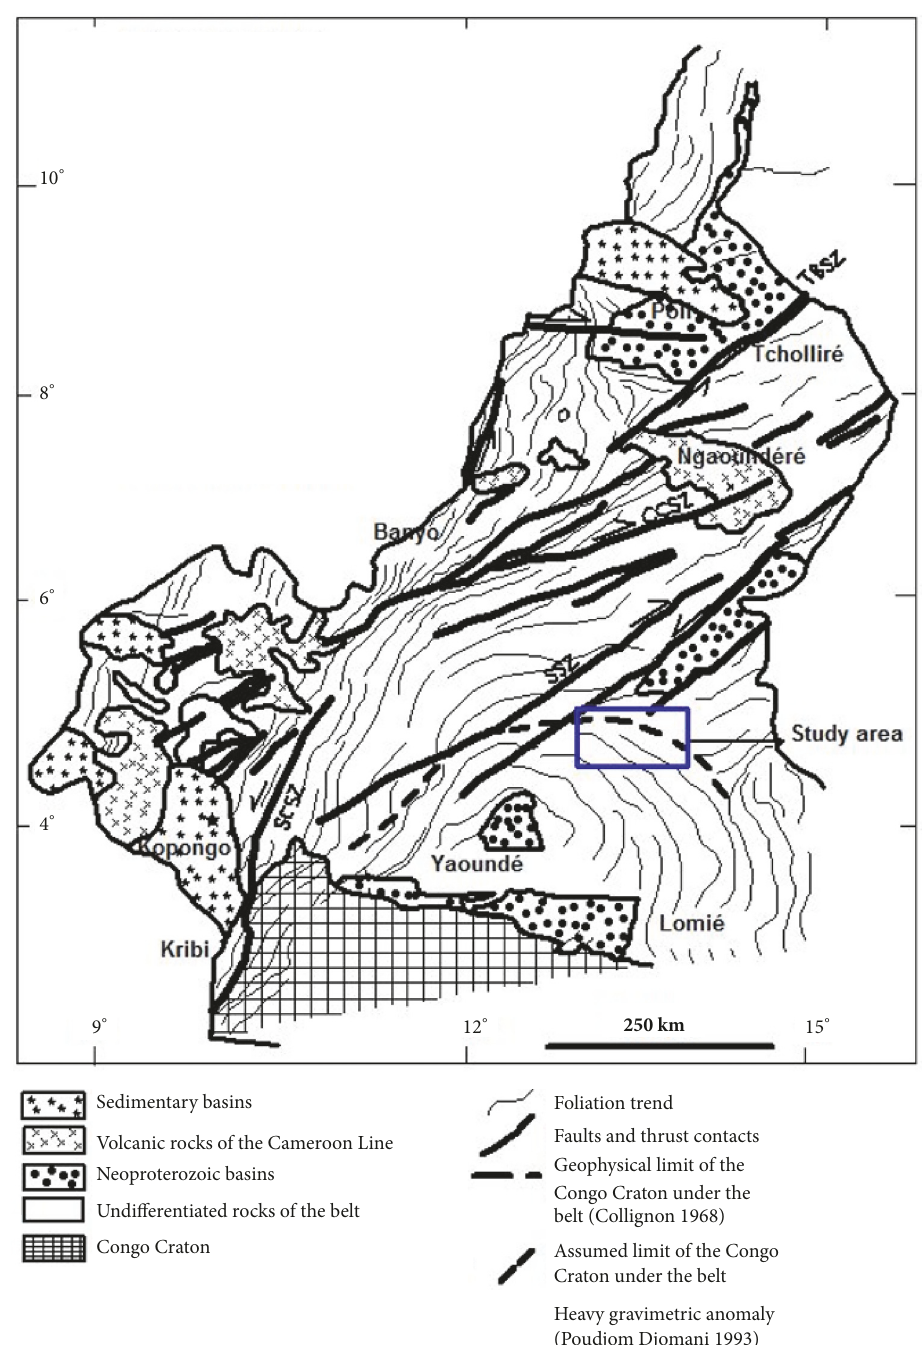
Figure 1: Foliation and lineation trends compiled from the previous geological reconnaissance maps of Cameroon at 1: 500,000000 modified by